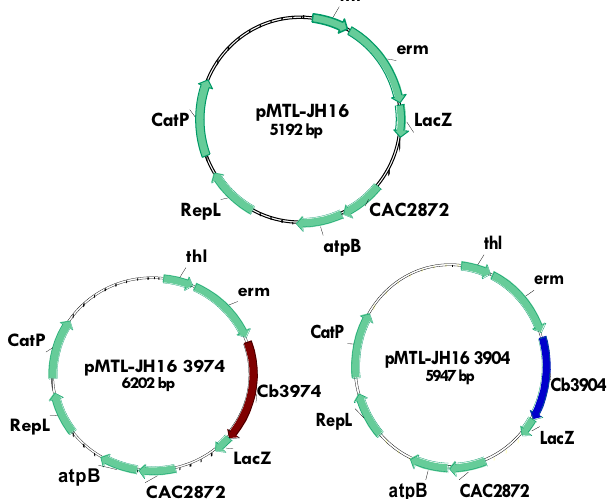
Figure 11. Construction of pMTL-JH16_3974 and pMTL-JH16_3904 from the parent plasmid,